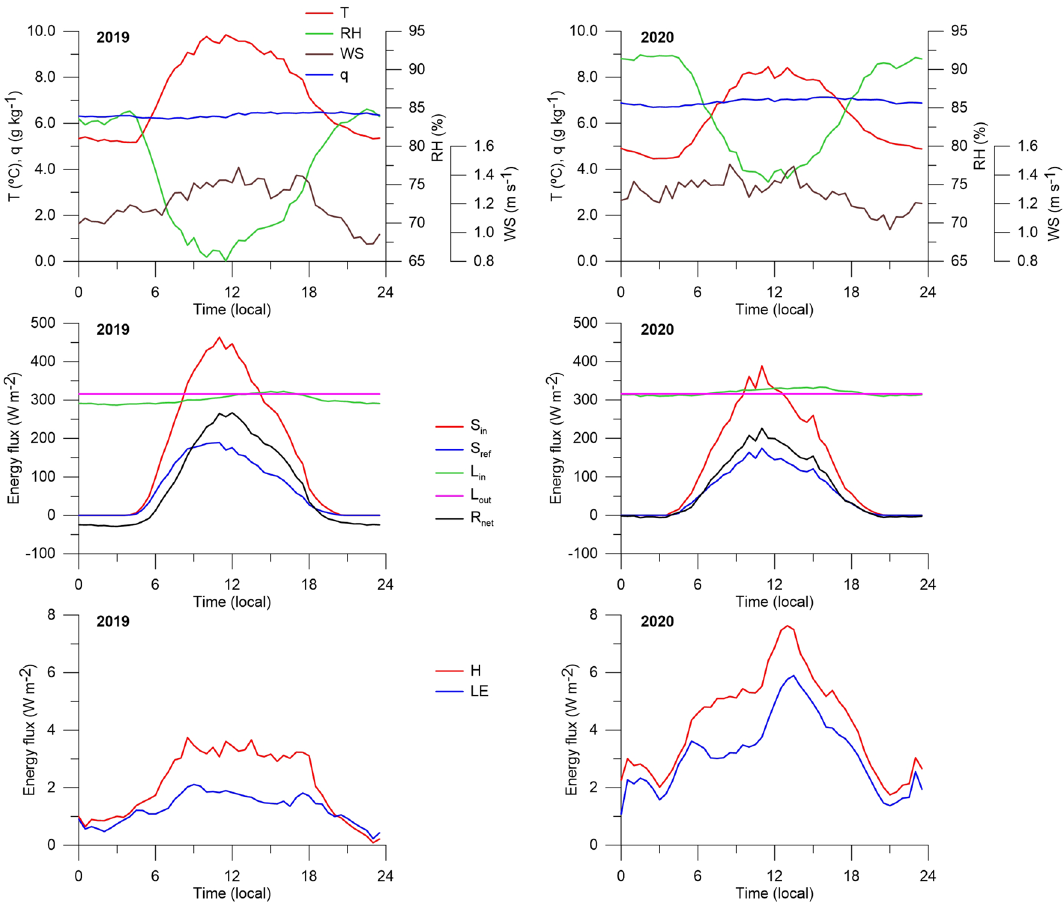
Figure 3. Mean daily cycle of meteorological parameters (2 m above the glacial surface) and energy fluxes during the 2019 and 2020 ablation seasons (for the period 7 July to 23 August): air temperature (T), relative humidity (RH), wind speed (WS), specific humidity (q), incoming (S in ) and reflected (S ref ) shortwave radiation, incoming (L in ) and outgoing (L out ) longwave radiation, net radiation (R net ), and sensible (H) and latent (LE) in solar radiation arriving at the top of the atmosphere. The lower amount of incoming solar radiation in 2020 compared to 2019 (21% less) is explained by more significant (17% more) cloud cover in 2020 (Table 1). S in has a distinct diurnal cycle (Fig. 3), with the daily range in 2019 being 1.2 times higher than in 2020. Reflected shortwave radiation (S ref , AWS1) is characterized by strong day-to-day variability and tends to decrease towards the end of the ablation season due to an increase in the glacial surface albedo (Fig. 4). At the same time, its interannual variability is relatively small (Table 1), since AWS1 is located near the long-term equi- librium line of the glacier, and the change of the snow surface from snow to ice occurs every year. The net shortwave radiation ranged from 11 to 225 W m −2 in 2019 (on average 90 W m −2 ) and from 11 to 160 W m −2 in 2020 (on average 67 W m −2 ). The net shortwave radiation in August was higher than in July (in 2019 by 7 W m −2 , in 2020 by 20 W m −2 ) due to a decrease in the reflected radiation in August (in 2019, by 3.4 times; in 2020, by 1.5 times).